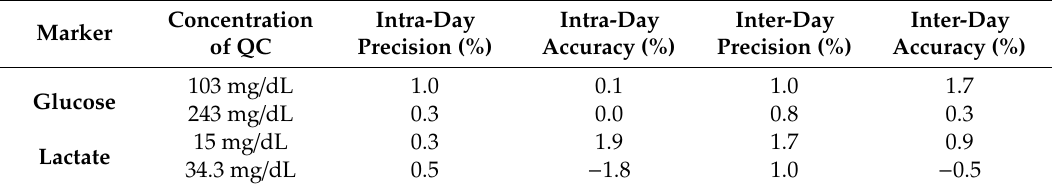
Table 3. Validation parameters of the method for determining glucose and lactate. QC samples: PreciControl ClinChem Multi 1 (low concentration) and 2 (high concentration) (cobas ® , Roche Diagnostics GmBH, Mannheim,